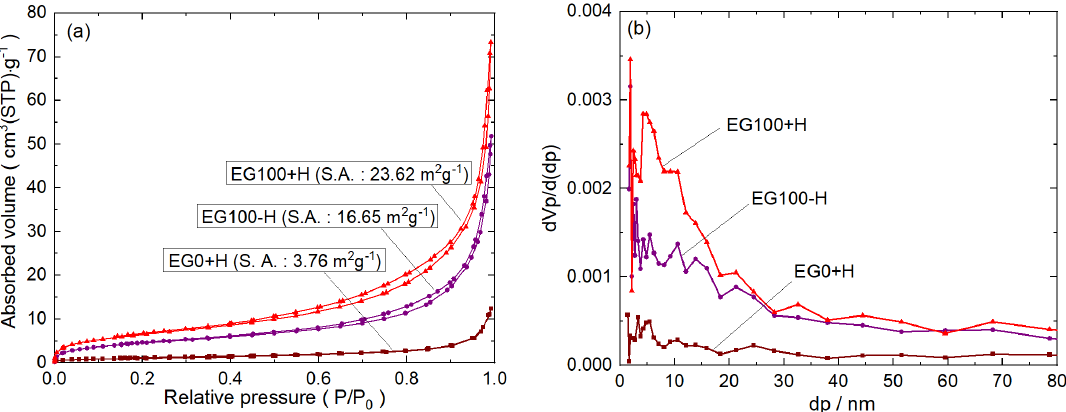
Figure 5. N 2 adsorption-desorption isotherms ( a ) and pore size distribution ( b ) for EG0-H, EG100-H and EG100+H samples.